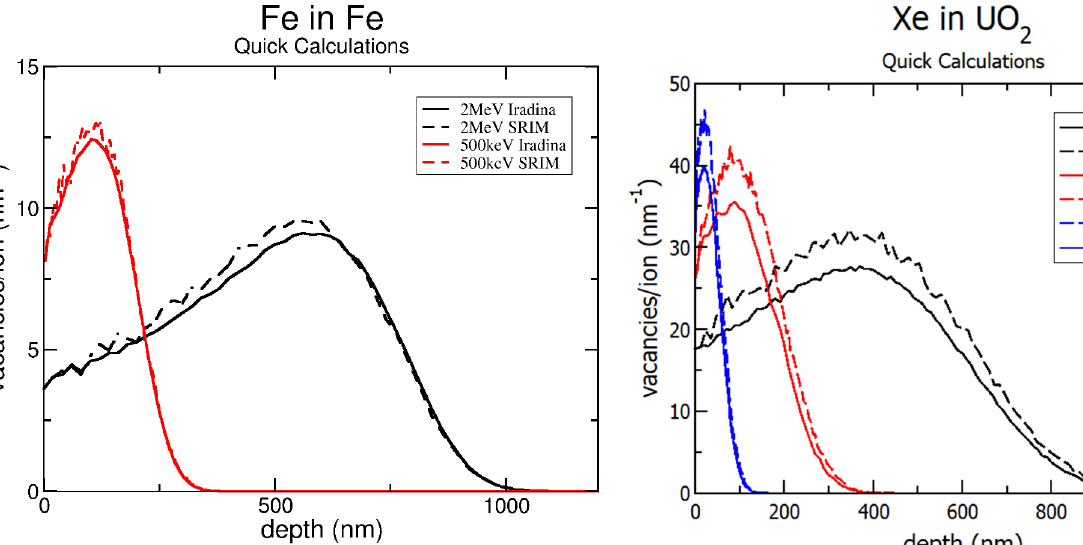
Fig. 1. Damage pro fi les for 2 MeV and 500 keV self-irradiation in iron estimated with quick calculation. Comparison between Iradina (solid lines) and SRIM (dashed